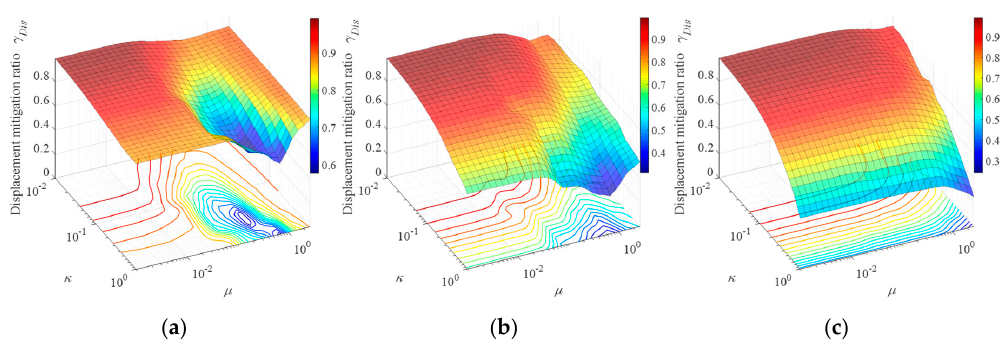
Figure 6. Variation of γ Dis for: ( a ) λ = 0.2, ( b ) λ = 1.00, and ( c ) λ = 1000.